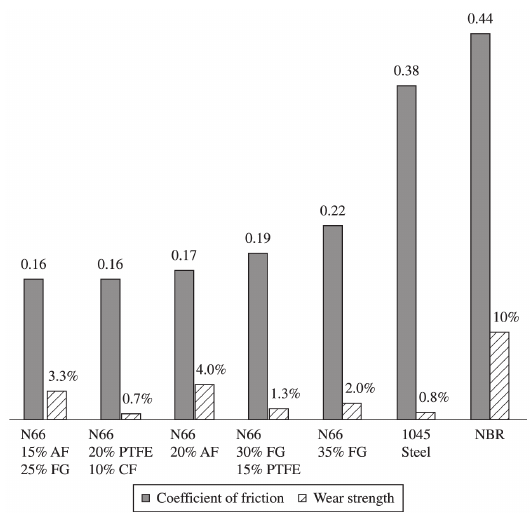
Figure 4. Comparison between the friction coefficient and